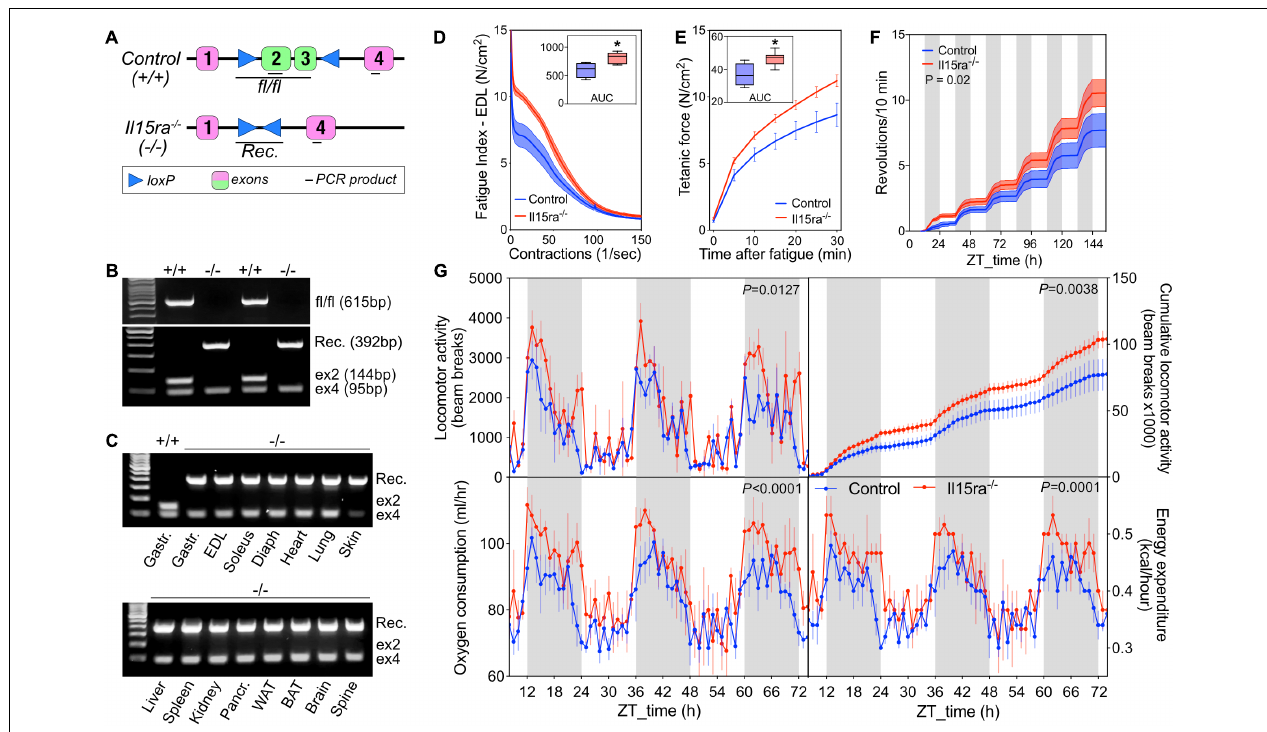
FIGURE 2 | Generation of C57BL/6-Il15ra − / − mice with enhanced exercise capacity. (A) Diagram of EIIA-cre-mediated genomic deletion of exons 2 and 3 of the Il15ra gene. (B) Genomic PCR for the detection of the intact Il15ra-flox alleles (615 bp), recombined genomic sequence after the cre-mediated flox excision (392 bp), exon 4 (95 bp), and exon 2 (144 bp, absent in fully recombined samples). (C) Genomic PCR to confirm the successful recombination in multiple tissues of Il15ra − / − mice, with consequent excision of the exon 2 sequence. Representative ex vivo EDL fatigue (D) and recovery (E) traces of control ( n = 4) and Il15ra − / − ( n = 6) mice. Insets show the average area under the curve (AUC). (F) Cumulative wheel running traces ( n = 5 mice per group). Cumulative distributions were compared with the Kolmogorov–Smirnov test. (G) Representative indirect calorimetry assay of control ( n = 5) and Il15ra − / − ( n = 3) mice. Data are represented as mean ± SEM. ∗ P < 0.05 and ∗∗ P <